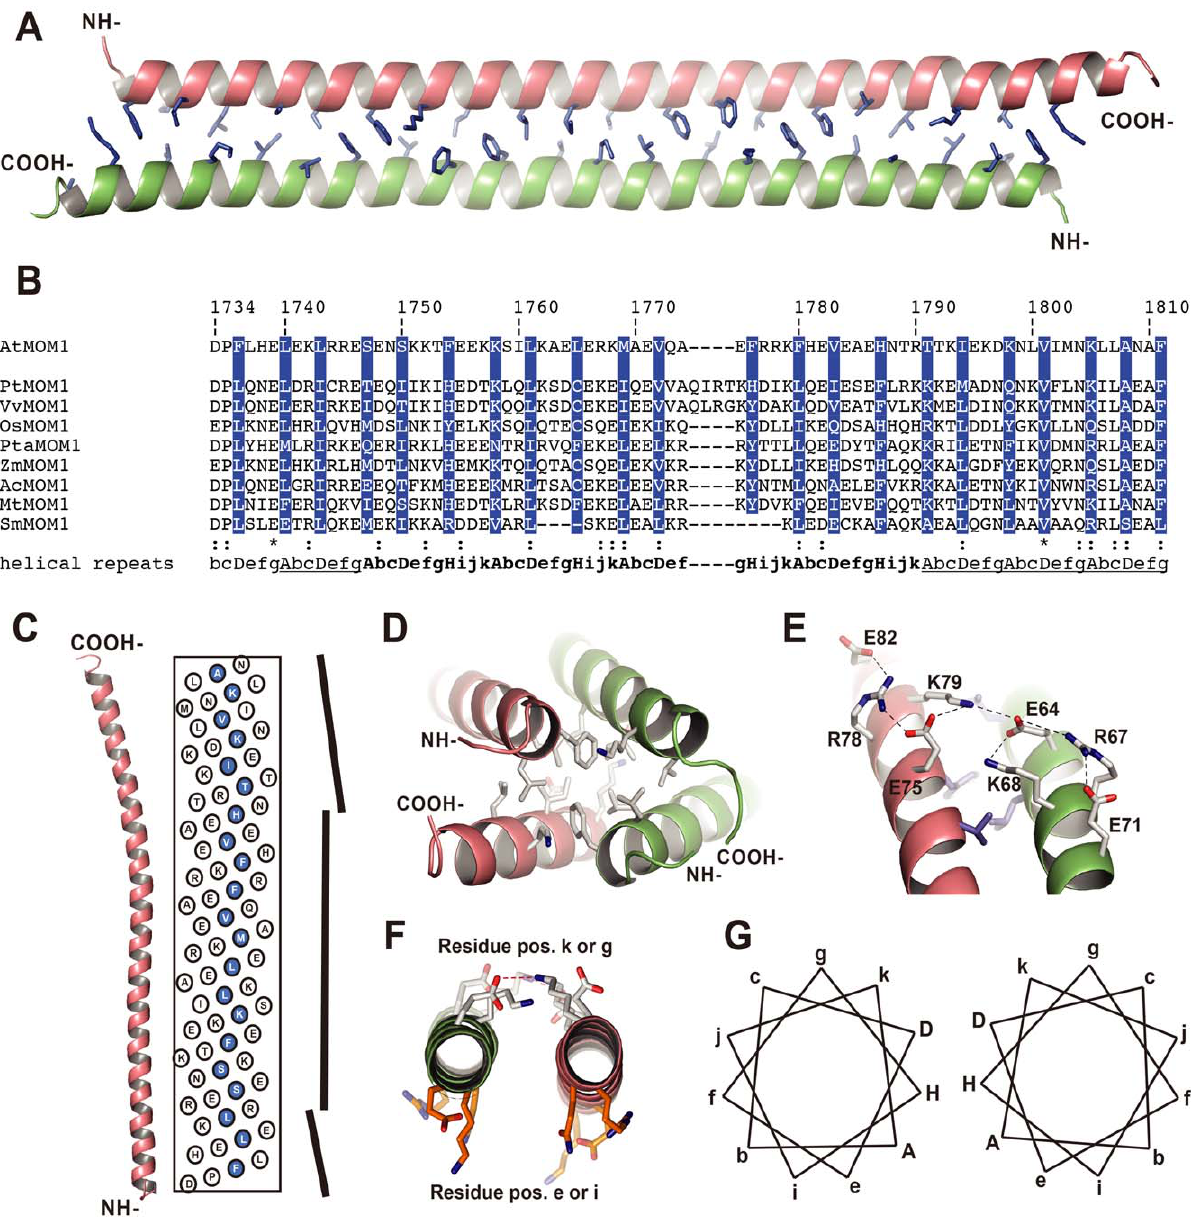
Figure 2. Crystal structure of the CMM2 protein fragment. (A) Overall view of the CMM2 coiled-coil structure. The two monomers are depicted as orange- and green-colored ribbons and the residues forming the interface are shown using the stick representation and colored in blue. (B) Sequence alignment of the different CMM2 sequences found in plants [24]. At - Arabidopsis thaliana , Pt - Populus trichocarpa , Vv - Vitis vinifera , Os - Oryza sativa , Pta - Pinus taeda , Zm - Zea mays , Ac - Aquilegia coerulea , Mt - Medicago truncatula , Sm - Selaginella moellendorffii. The hydrophobic residues forming the interphase are highlighted in blue (shown in A). The repeated pattern of amino acids is indicated in letters referring to their positions. Heptad repeats are underlined and hendecad’s repeats are in bold. (C) Axial view of the CMM2 monomer structure together with the radial net showing the position of each amino acid on a flat surface. The vertical bars on the right side represent change in the a -helical axis direction. The N-terminus is at the bottom and the C-terminus on top. Amino acids at position A, D and H are highlighted in blue. (D) Hydrophobic interface formed by the tips of the CMM2 monomers. Symmetry-related CMM2 monomers are depicted as orange- and green-colored ribbons. Amino acids involved in the interaction are show as sticks and colored according to their atom types (carbon: white, nitrogen: blue, oxygen, red). (E) View of the intra- and intermolecular salt bridges stabilizing the CMM2 coiled-coil. Amino acids are labeled and depicted as in panel D. Hydrogen bonds are shown as dashed lines. (F) View along the axis of the CMM2 helices illustrating the difference between the orientation of amino acids in positions e or i and in positions k or g. (G) Schematic representation of the amino acid positions in the CMM2 anti-parallel coiled-coil structure. Positions forming the hydrophobic interface are in capital letters. Images were prepared with the program PyMOL (W.L. Delano, The PyMOL Molecular Graphics System, DeLano Scientific, Palo Alto, CA (2002)).